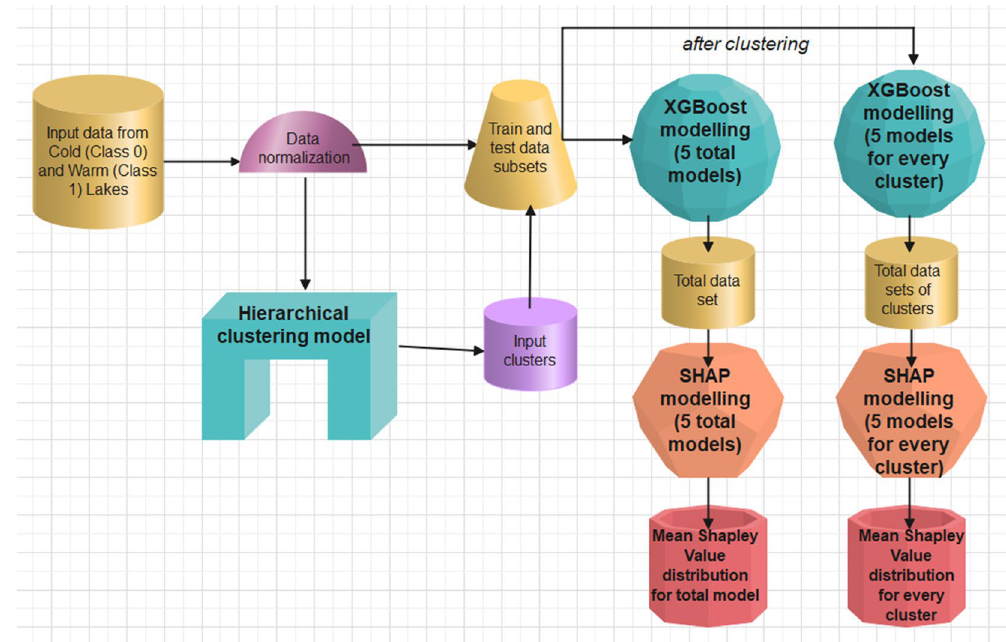
Figure 5. The scheme of the prediction modelling with alternative paths with and without